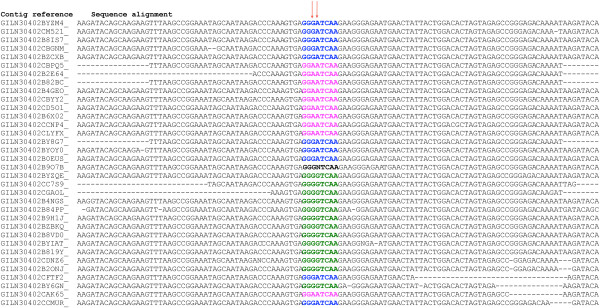
D222 variants obtained by deep sequencing of sample 405. Schematic representation of two nucleotide variations, 715 and 716 (N1 position), arrows indicate both positions of the HA sequence, and the alignment image of the 100-mer reads. Every read shown in blue wild type GAT (D), in pink AAT (N), in green GGT (G) and in black undefined codon. Reference sequence was A/Mexico/InDRE4487/2009(H1N1).